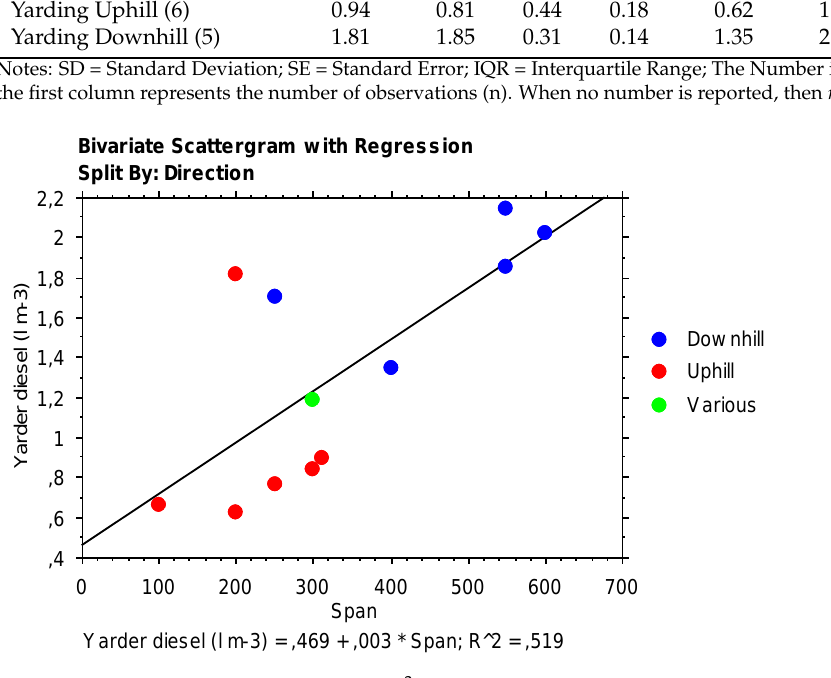
Figure 3. Yarder fuel consumption (L m − 3 ) as a function of line span (m).